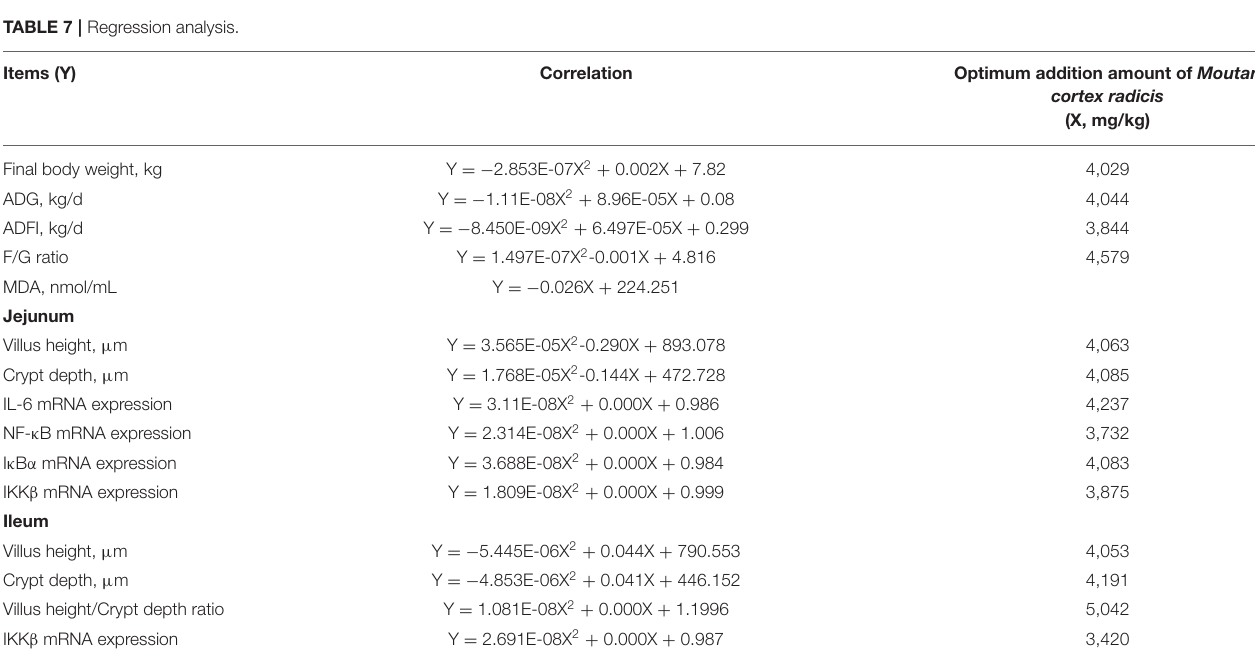
TABLE 7 | Regression